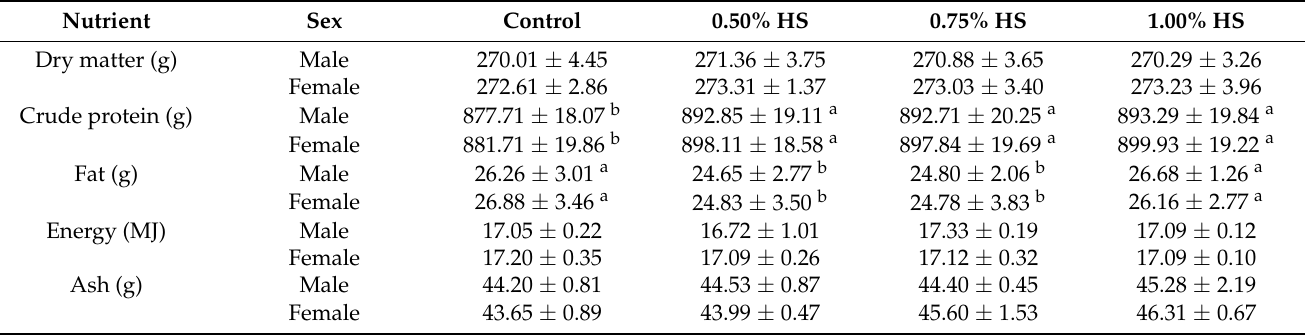
Table 4. The effect of HSs on the content of nutrients in breast